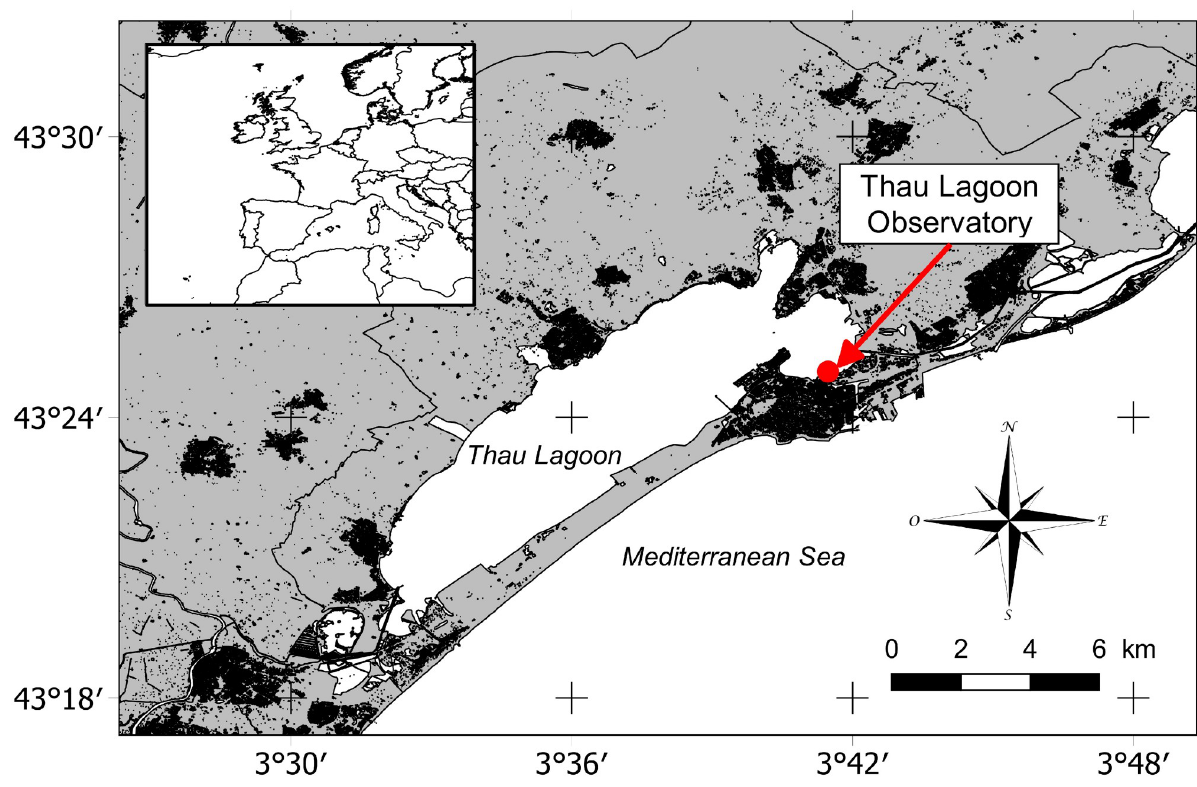
Fig 1. Location of the sampling